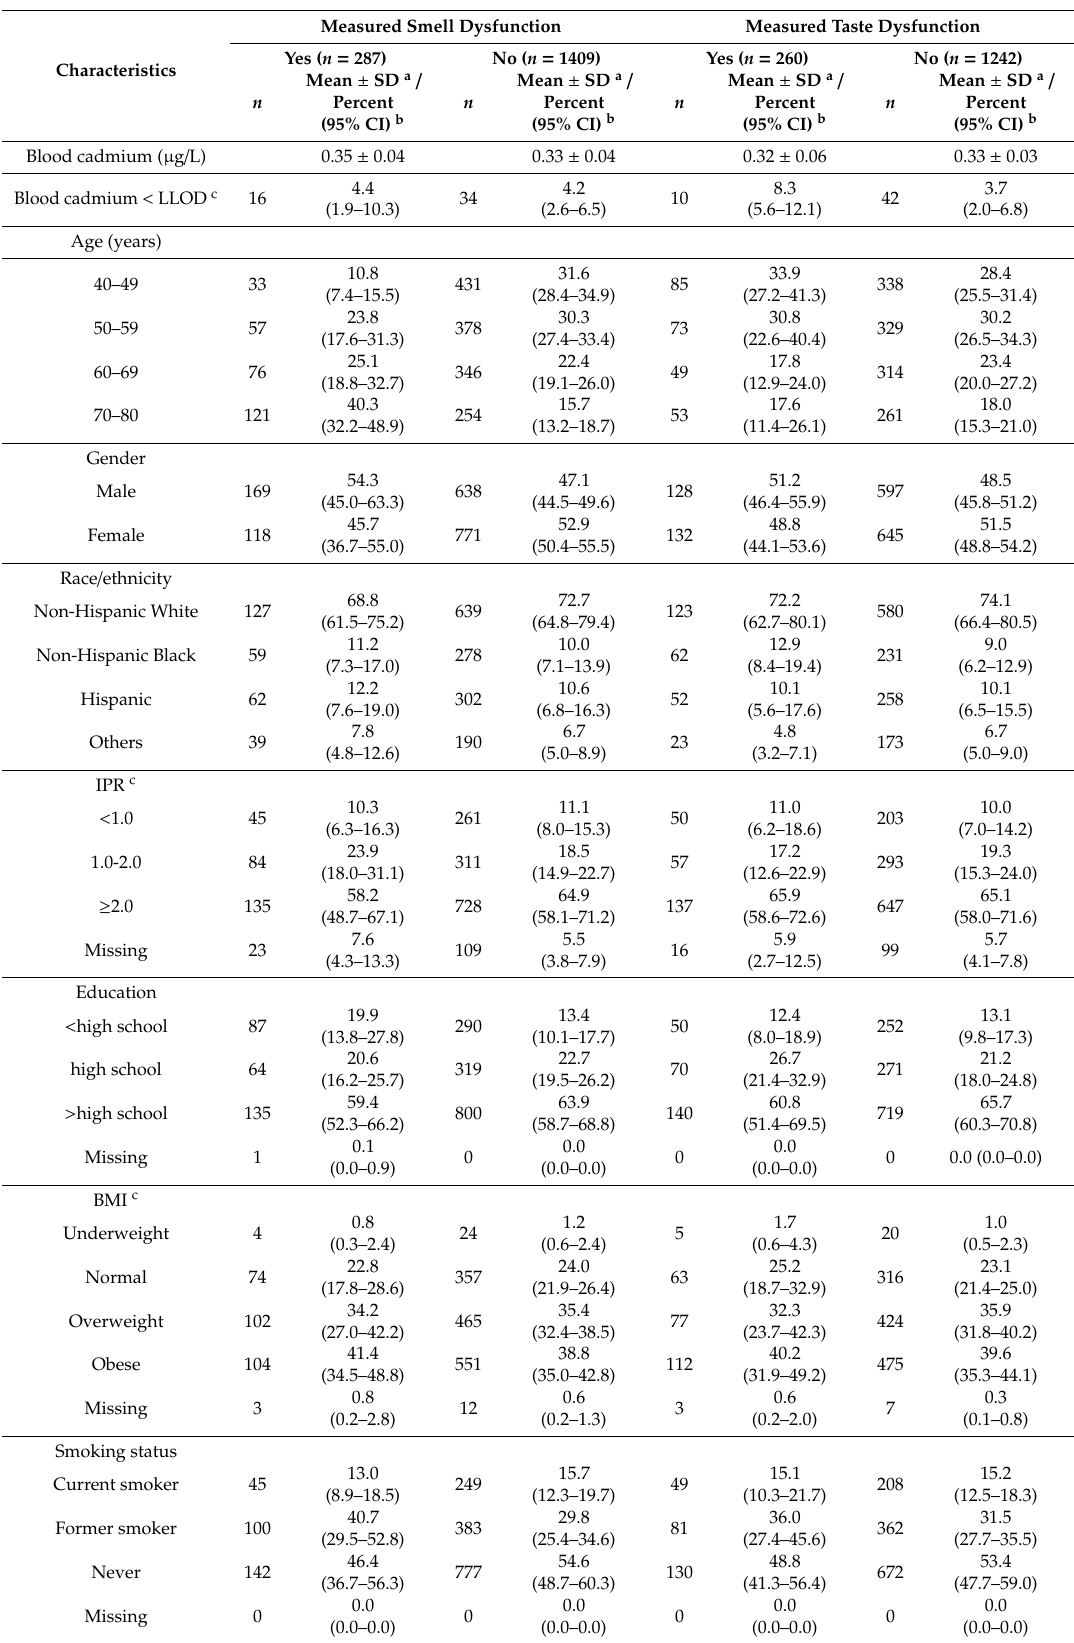
Table 2. Distributions of characteristics by objectively measured taste and smell dysfunction among adults in the NHANES 2011–2014 ( n =